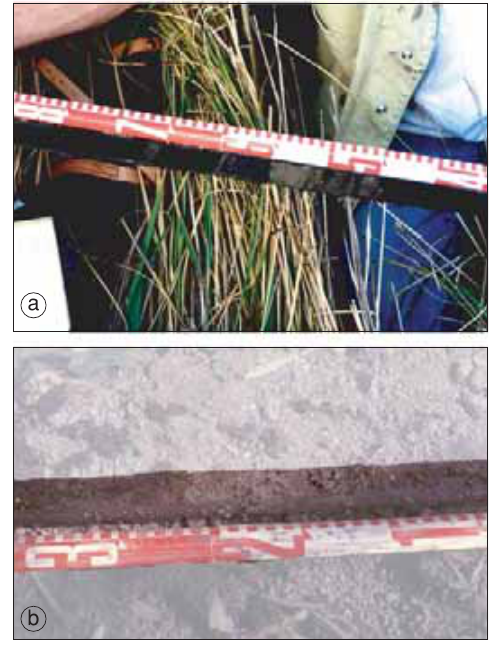
Fig. 9a,b. a) Picture of the Event L3 sand found at Black Panther site; b) picture of Event S3 sand collected at Mr. Paolo’s site.